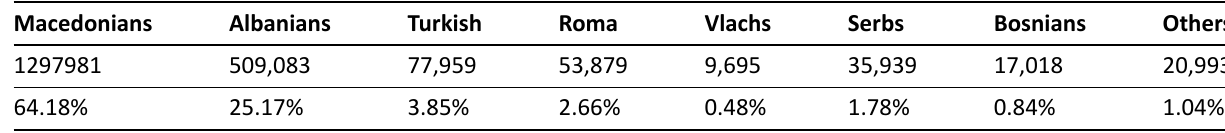
Table 1. Population structure according to national affiliation in 2002 census.